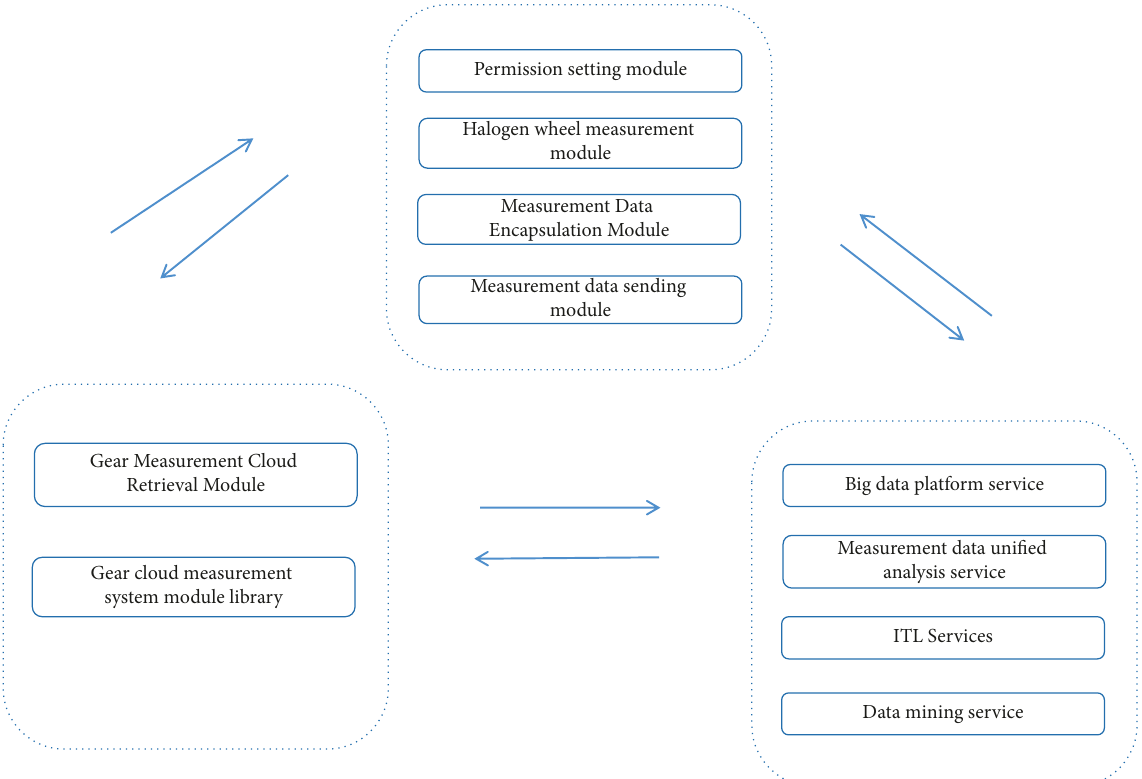
Figure 6: Four types of errors during hobbing of noncircular gears.